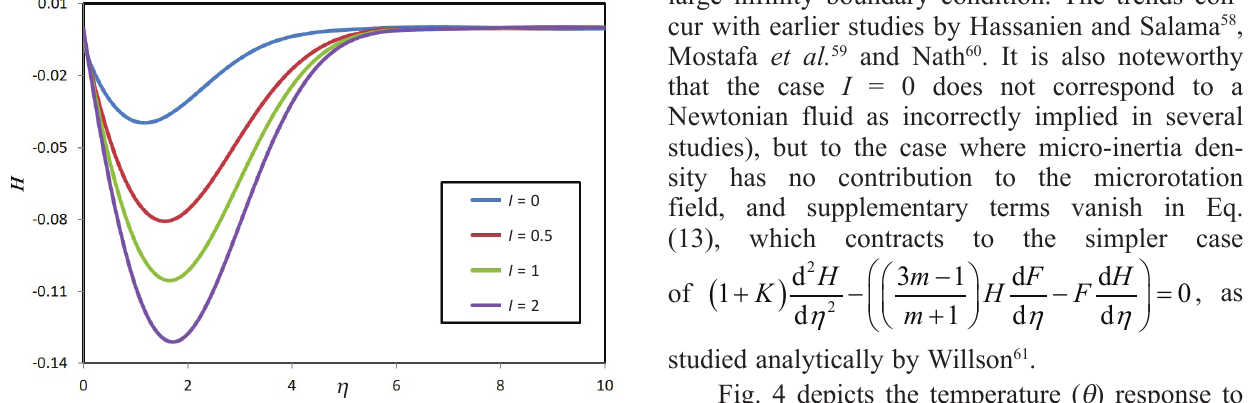
Fig. 3 – H (angular velocity) versus h for K = 0.5, Ec = 0.2, F = –0.5 (heat sink), Pr =100 (weak polymers), m = 0.3 (gen- eral wedge flow) with micro-inertia density parameter (I)